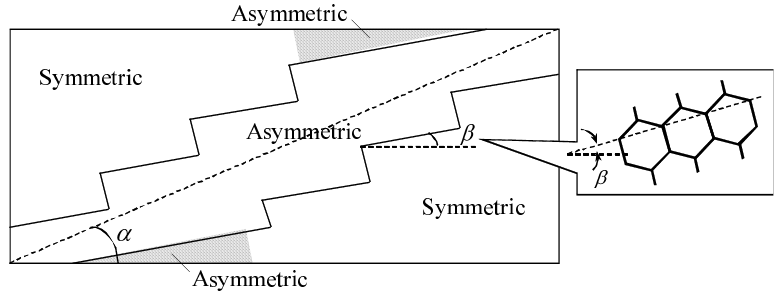
Figure 9. Schematic representation of deformation in Type II